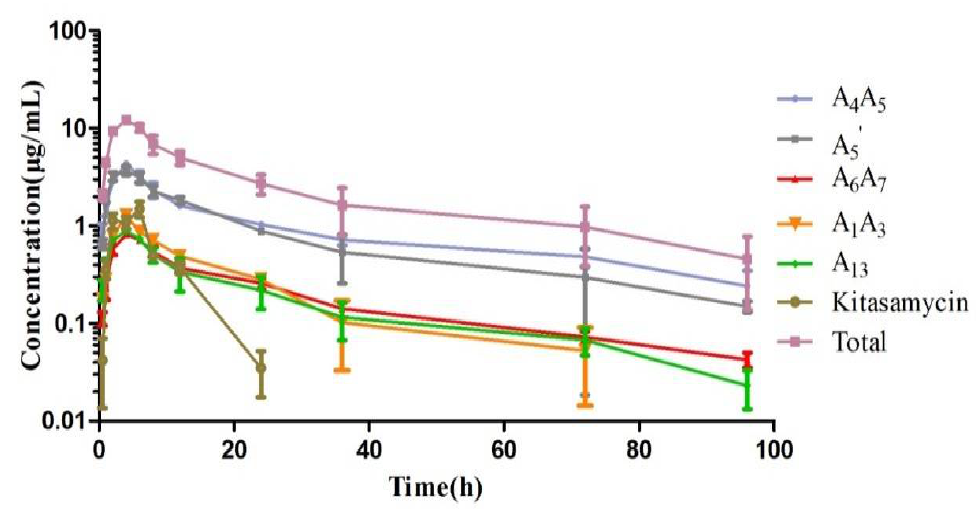
Figure 4. Acetylkitasamycin concentrations in PELF-versus-time curves plotted semilogarthmically for data obtained after intragastric